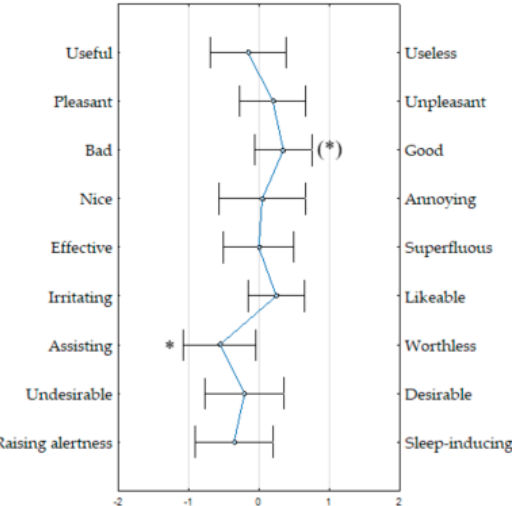
Figure 6. Means and 95% confidence intervals for the acceptance of the SICD. Significant differences from the scale mean are marked with *, nearly significant differences with (*).